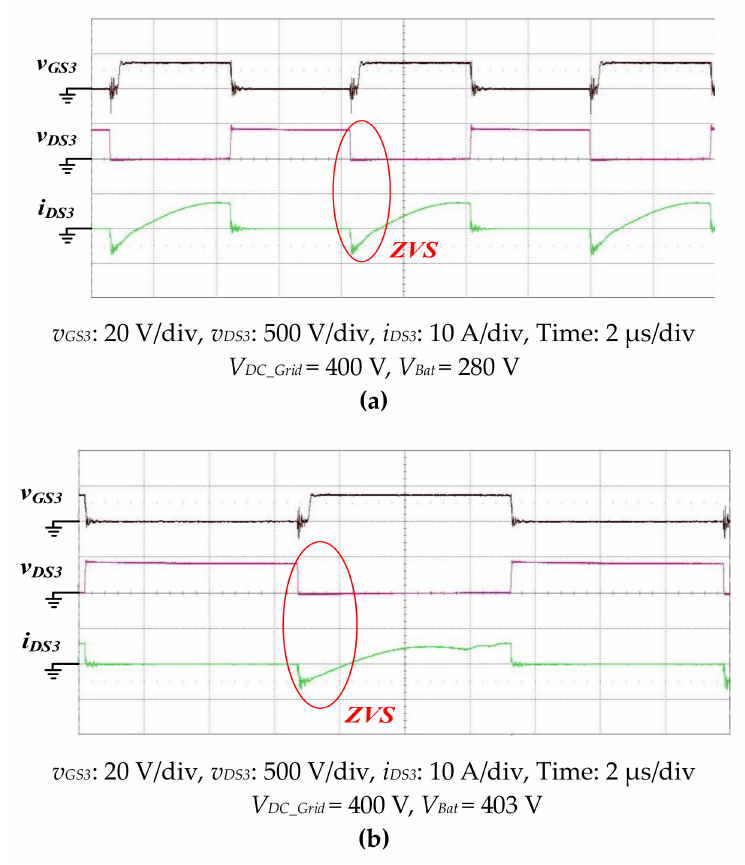
Figure 16. Waveforms of v GS3 , v DS3 , and i DS3 with two battery voltages: ( a ) V Bat = 280 V; ( b ) V Bat = 403